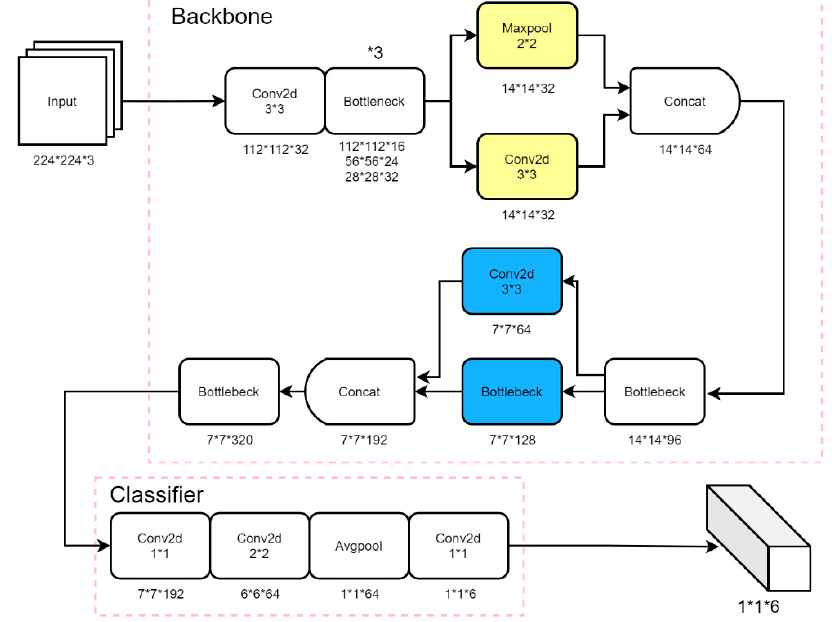
Figure 2. Improved MobileNetV2 network structure.